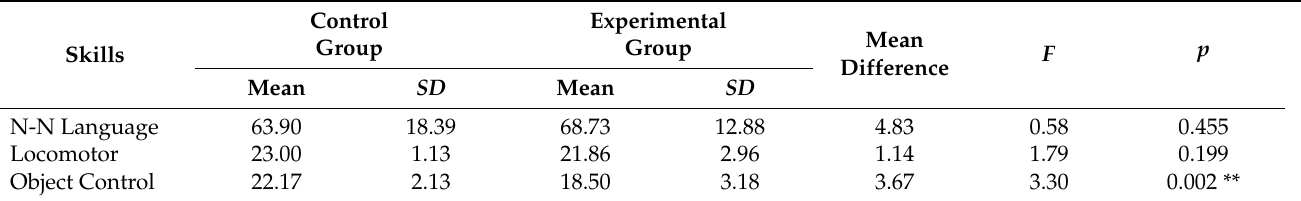
Table 1. Differences between groups before the intervention in terms of the non-native language and motor skills.